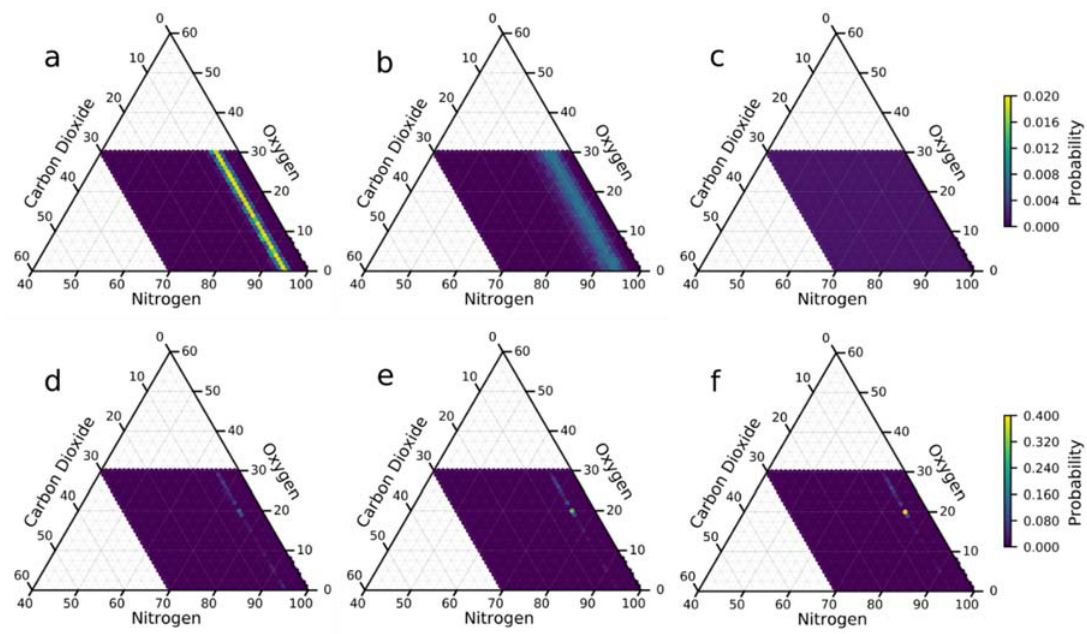
Figure 2. ( a – c ) Ternary discrete probability plots of ( a ) the best (Mg-MOF-74 [44]), ( b ) median Figure 2. (a − c) Ternary discrete probability plots of (a) the best (Mg ‐ MOF ‐ 74 [44]), (b) median (Cu 4 I 4 (DABCO) 2 MOF [45]), and ( c ) worst (La(PODC) 1.5 (H 2 O) MOF [46]) 1-element arrays. ( d – f ) Ternary discrete probability plots of the best ( d ) 5-, ( e ) 15-, and ( f ) 25-element arrays. Please note (Cu 4 I 4 (DABCO) 2 MOF [45]), and (c) worst (La(PODC) 1.5 (H 2 O) MOF [46]) 1 ‐ element arrays. (d − f) the change in scale of the color bar for the plots in ( a – c ) versus the plots in ( d – f Ternary discrete probability plots of the best (d) 5 ‐ , (e) 15 ‐ , and (f) 25 ‐ element arrays. Please note the change in scale of the color bar for the plots in ( a − c) versus the plots in (d − f) .